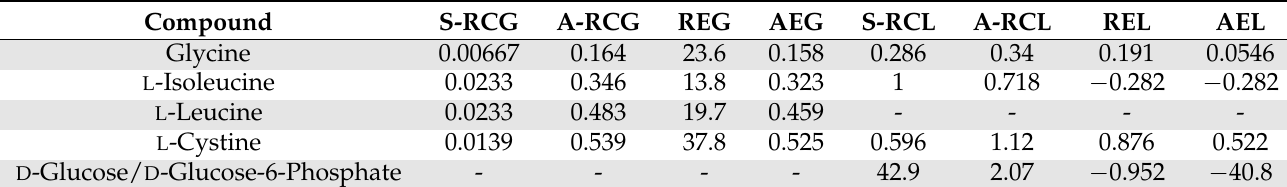
Table 4. Results from the ASICS quantifier. The column headings are defined for this quantifier (with prefix A- )